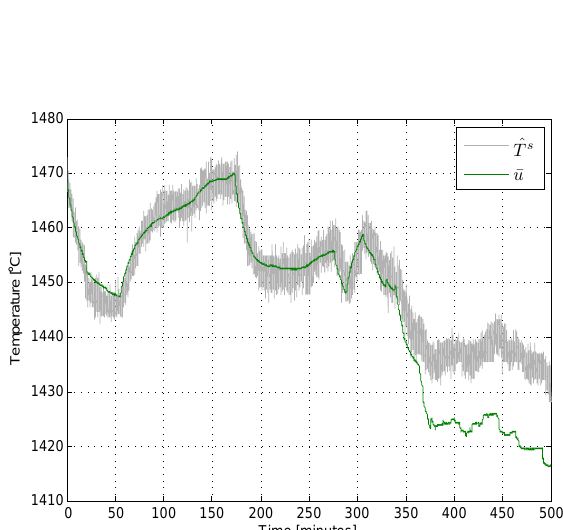
Figure 18: The rescaled graphite pyrometer, ¯ u , and the silicon pyrometer, ˆ T s , over an extended time period.